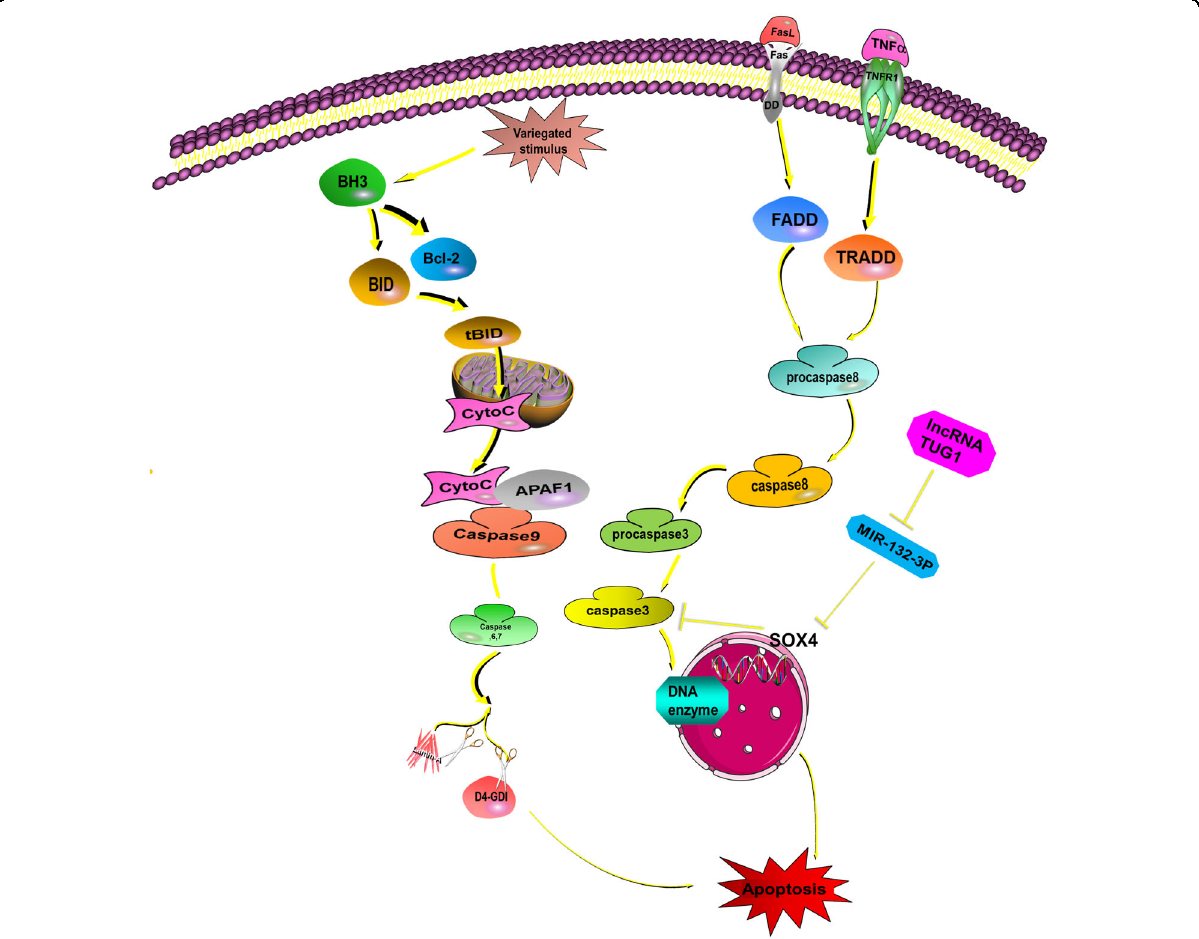
Fig. 1 Activation of the apoptotic pathway. Apoptosis can be divided into the extrinsic pathway and intrinsic pathway. In the extrinsic pathway, the death receptor TNFR, Fas/CD95, and TRAIL combine with the relevant factors from extracellular, such as TNF, FasL. Then, the death receptor, procaspase-8, caspase-8, and caspase-3 are sequentially activated and regulate DNA fragmentation factor (DFF)/caspase-activated DNase (CAD) and cause apoptosis 26,27,36 . In the intrinsic pathway, cytotoxic stimuli such as carcinogenic stress, chemotherapeutic agents, and developmental cues activate BH3-only family members and inhibit Bcl-2 proteins, thus activating the pro-apoptotic effectors BAX and BAK, which fi nally destroy the outer mitochondrial membrane. This releases cytochrome C and ATF endonuclease. Cytochrome C engages APAF1 and forms the apoptosome, which activates caspase-9. Subsequently, caspase-9 activates caspase-3, caspase-6, and caspase-7, which contribute to the cleavage of other proteins and eventually promote apoptosis. Various lncRNAs are involved in this process. For instance, TUG1 can inhibit miR-132-3p expression, thereby increasing SOX4 expression. This decreases caspase-3 activity, eventually inhibiting osteosarcoma (OS) cell apoptosis. This indicates that knockdown of TUG1 could regulate the miR-132-3p – SOX4 axis in OS cells and promote